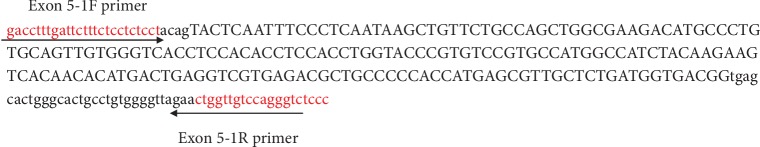
Nucleotide sequence of the amplified PCR product (265 bp) representing exon 5 of rat p53 gene in the HCC-induced group.